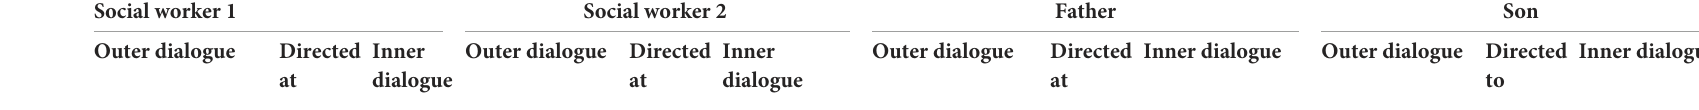
TABLE 2 Analysis matrix sharing of